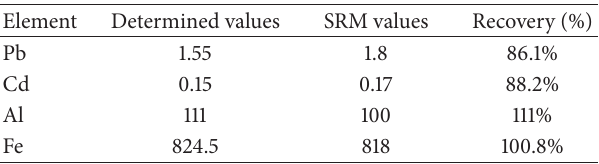
Table 4: Validation of extraction and analysis of standard